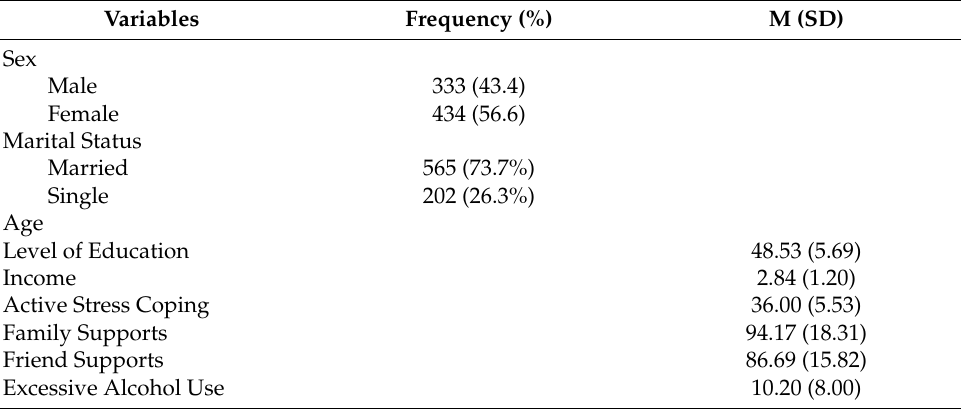
Table 1. Descriptive statistics of the sample (n =